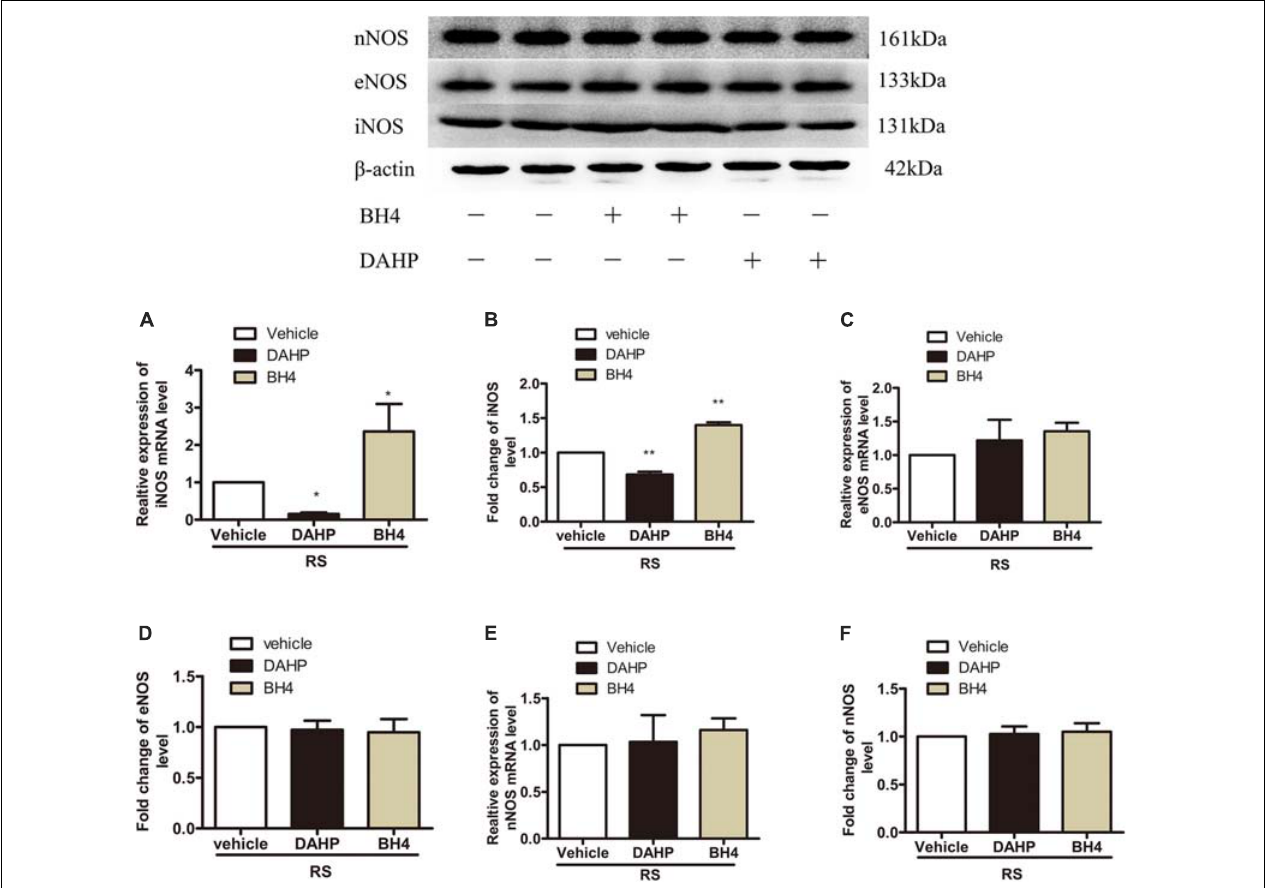
FIGURE 6 | Effect of either DAHP or BH4 intrathecal administration on the expression of three spinal NOS isoforms. (A,B) The expression of spinal iNOS mRNA ( F 2 , 9 = 6.869, P = 0.015) and protein ( F 2 , 9 = 123.036, P < 0.001) in rats treated with DAHP or BH4. (C,D) The expression of spinal eNOS mRNA ( F 2 , 9 = 0.879, P = 0.448) and protein ( F 2 , 9 = 0.081, P = 0.923) in rats treated with DAHP or BH4. (E,F) The expression of spinal nNOS mRNA ( F 2 , 9 = 0.223, P = 0.804) and protein ( F 2 , 9 = 0.131, P = 0.879) in rats treated with DAHP or BH4. Data are shown as mean ± SEM ( n = 4). *Significant difference with respect to vehicle groups (one-way ANOVA followed by Bonferroni post hoc test or Dunnett’s T3 test if necessary). * P < 0.05 and ** P < 0.01. BH4, tetrahydrobiopterin; NOS, nitric oxide synthase; iNOS, inducible nitric oxide synthase; eNOS, endothelial nitric oxide synthase; nNOS, neuronal nitric oxide